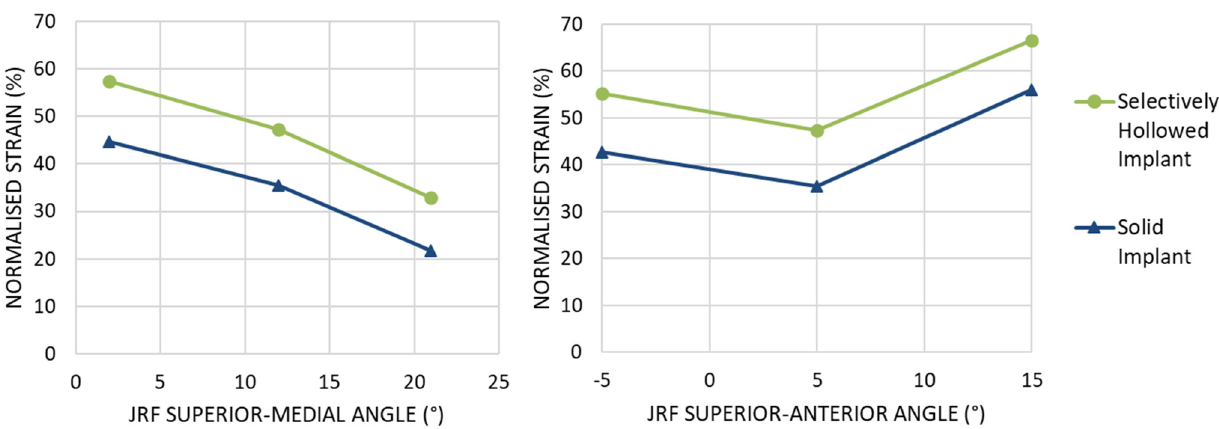
Figure 10. Peri-implant surface bone strain as a percentage of the strain measured for the native femur at Gruen zone 6 for different angles of joint reaction force (JRF). (Left) Variation in the coronal plane. (Right) Variation in the sagittal plane. For all load cases examined, the selectively hollowed implant resulted in less strain shielding than the solid reference